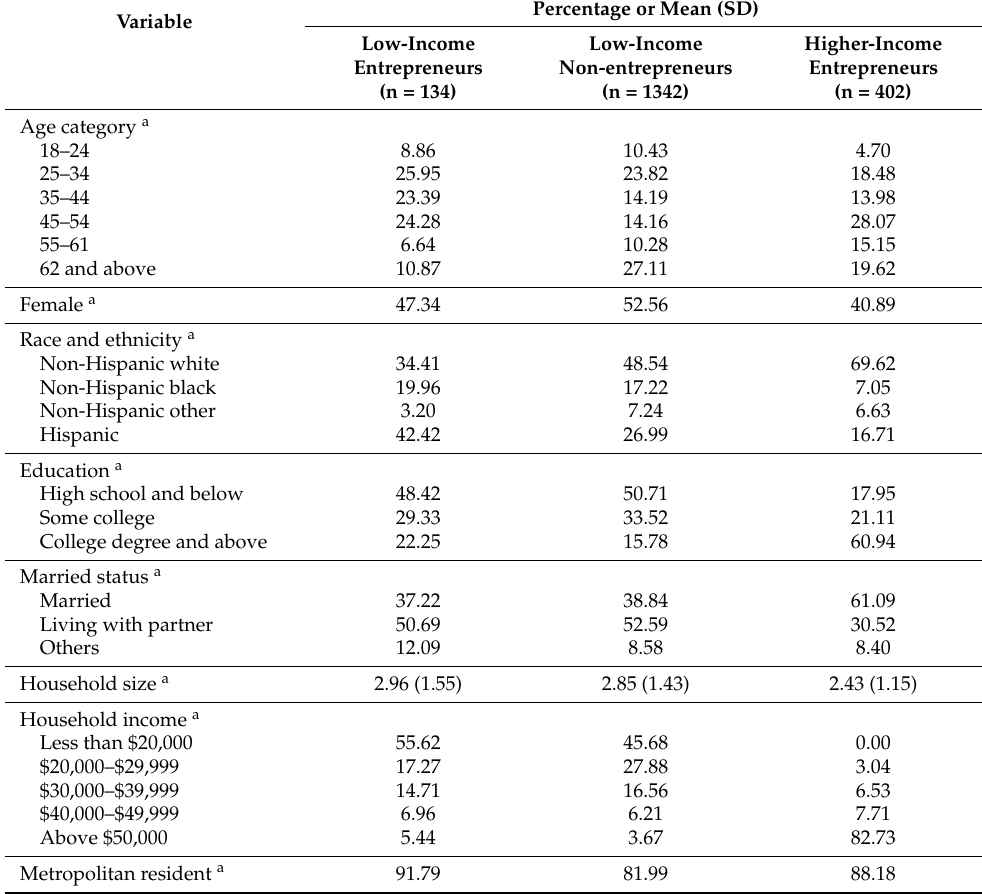
Table 2. Weighted sample characteristics (N =